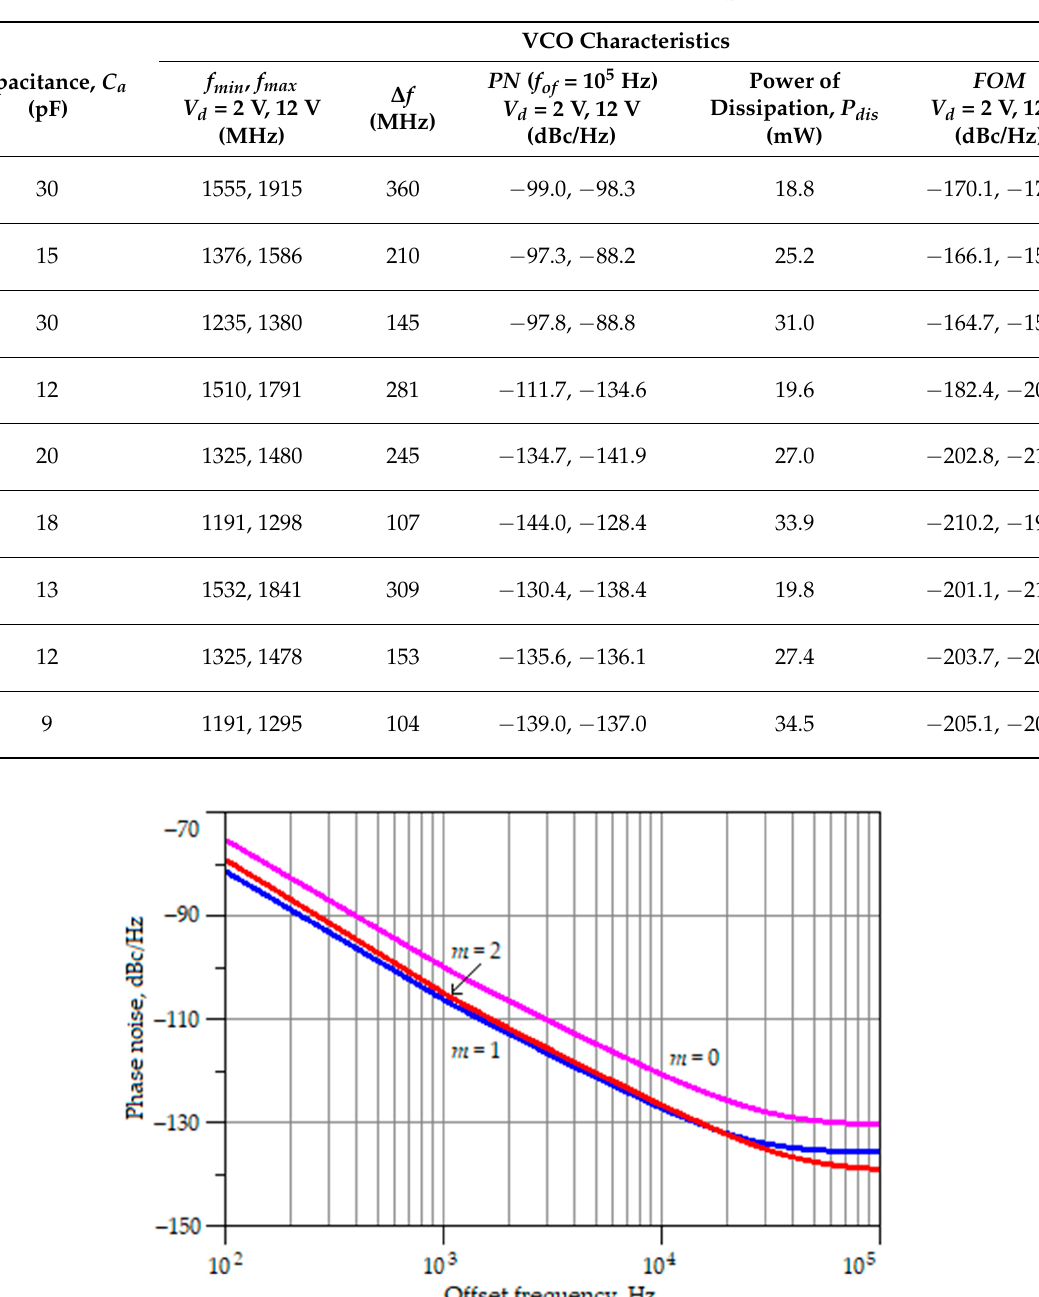
Figure 27. Phase noise versus offset frequency for VCO with multiple-output improved Wilson current mirror when V d = 2 V, R L = 50 Ω ; m = 0—purple curve ( C a = 13 pF), m = 1—blue curve ( C a = 12 pF), m = 2—red curve ( C a = 9 pF).